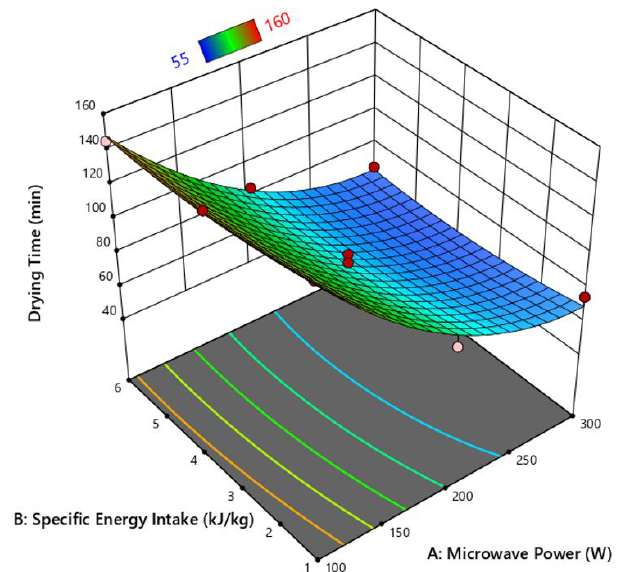
Figure 1. Drying curves of microwave-convective drying of apples untreated or PEF-pretreated. The p -Value (model) < 0.05 and p -Value (lack of fit) > 0.05 indicate a significant fitting of the model.